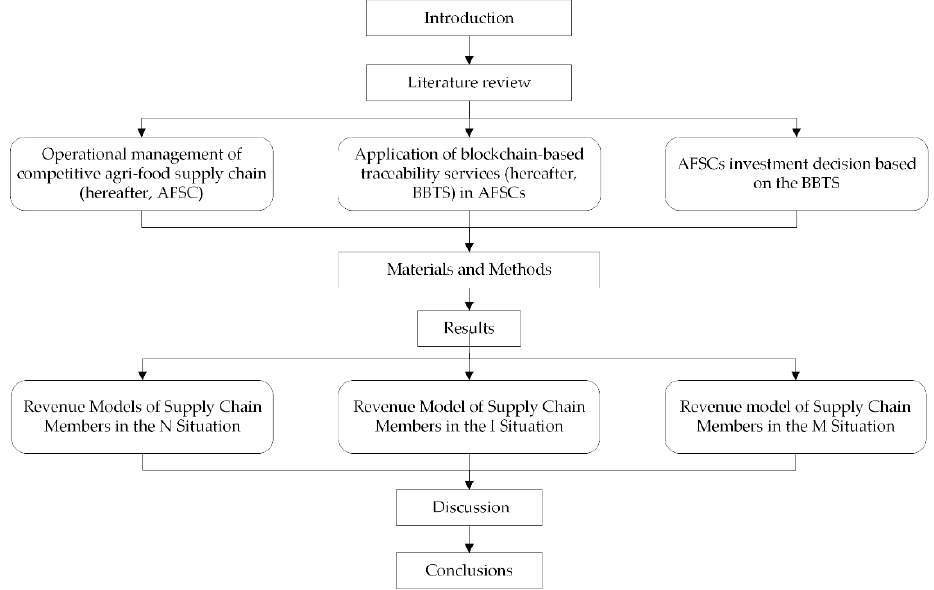
Figure 1. Article structure.